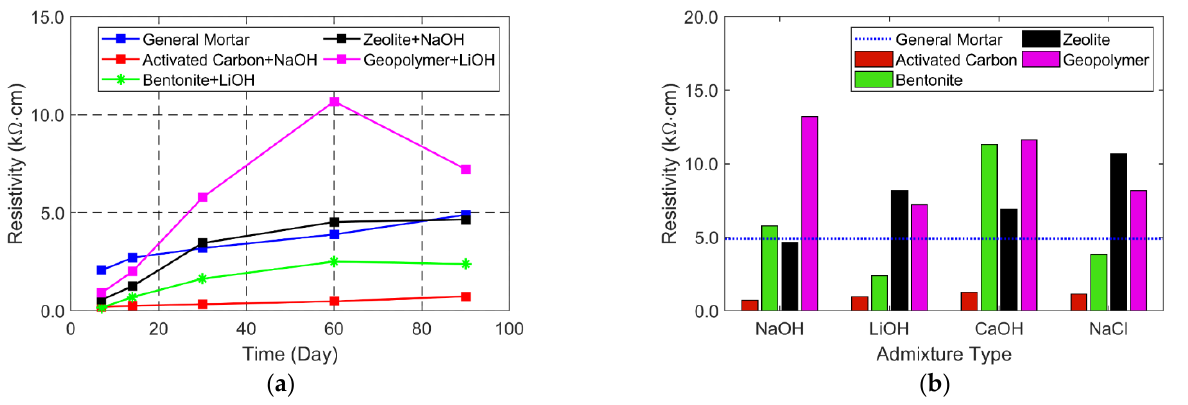
Figure 5. Resistivity variation during the 90 days after mortar specimens were made ( a ) and resistivity after 90 days ( b ) at different admixtures and chemical agents.